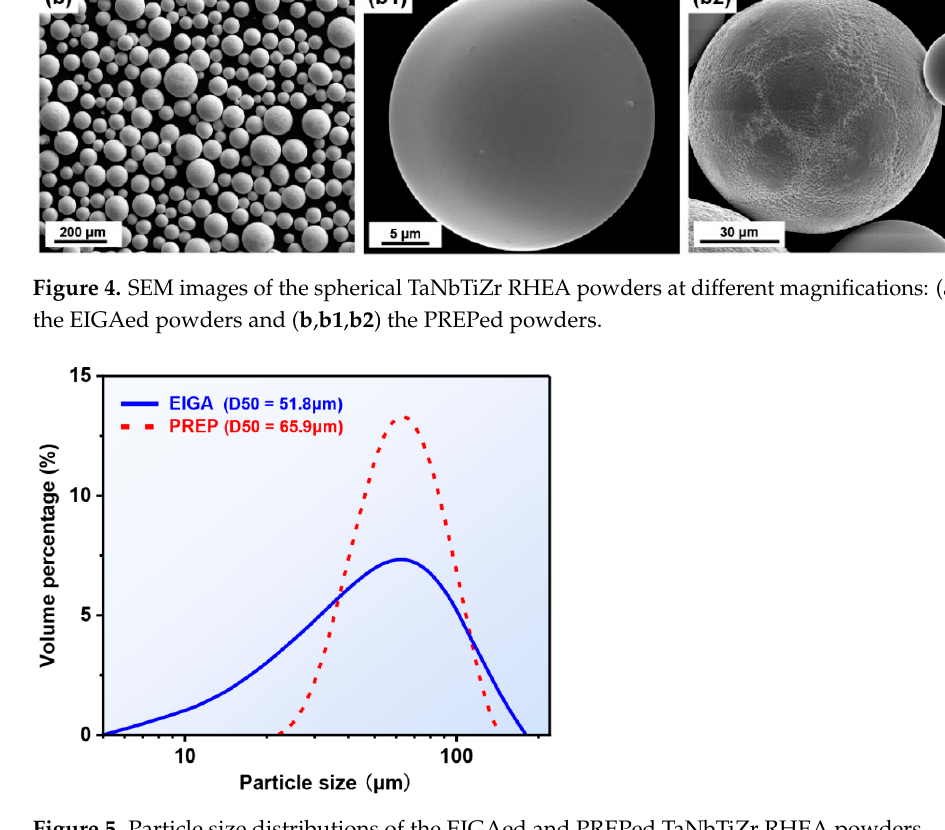
Figure 5. Particle size distributions of the EIGAed and PREPed TaNbTiZr RHEA powders.